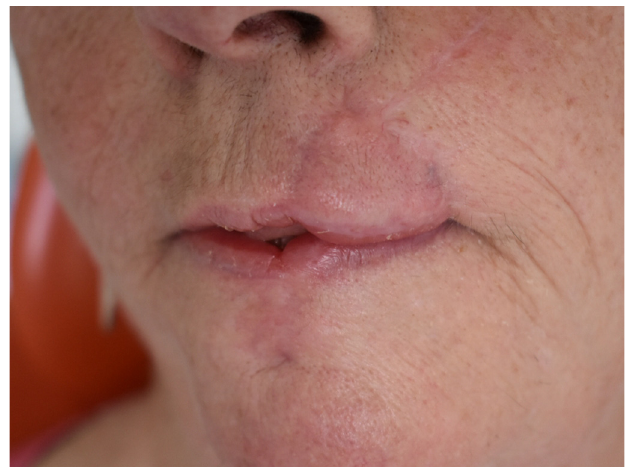
Fig. 6. Aspect of the scar 6 months after